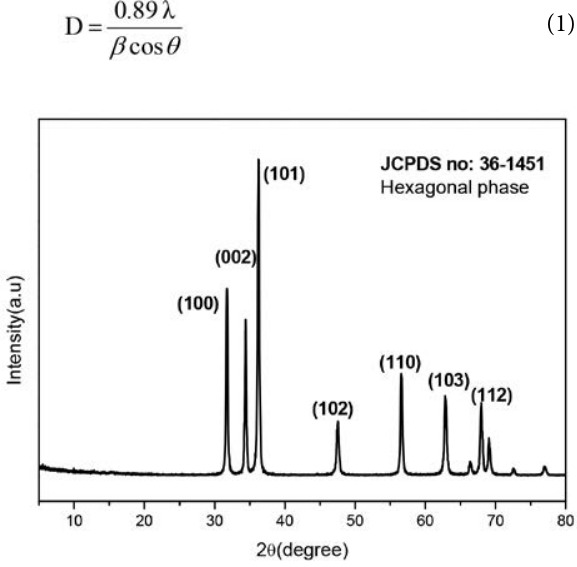
Figure 1. XRD pattern of ZnO